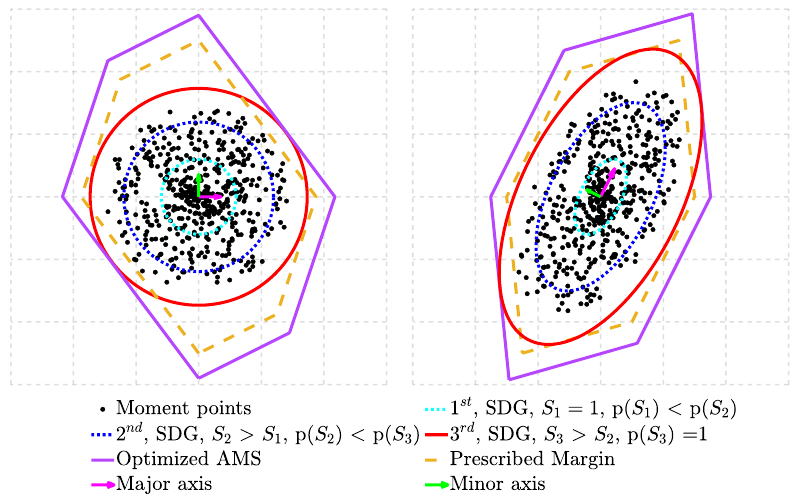
Figure 4. 2D visualization of the optimization problem formulation of fitting SDG into the AMS.